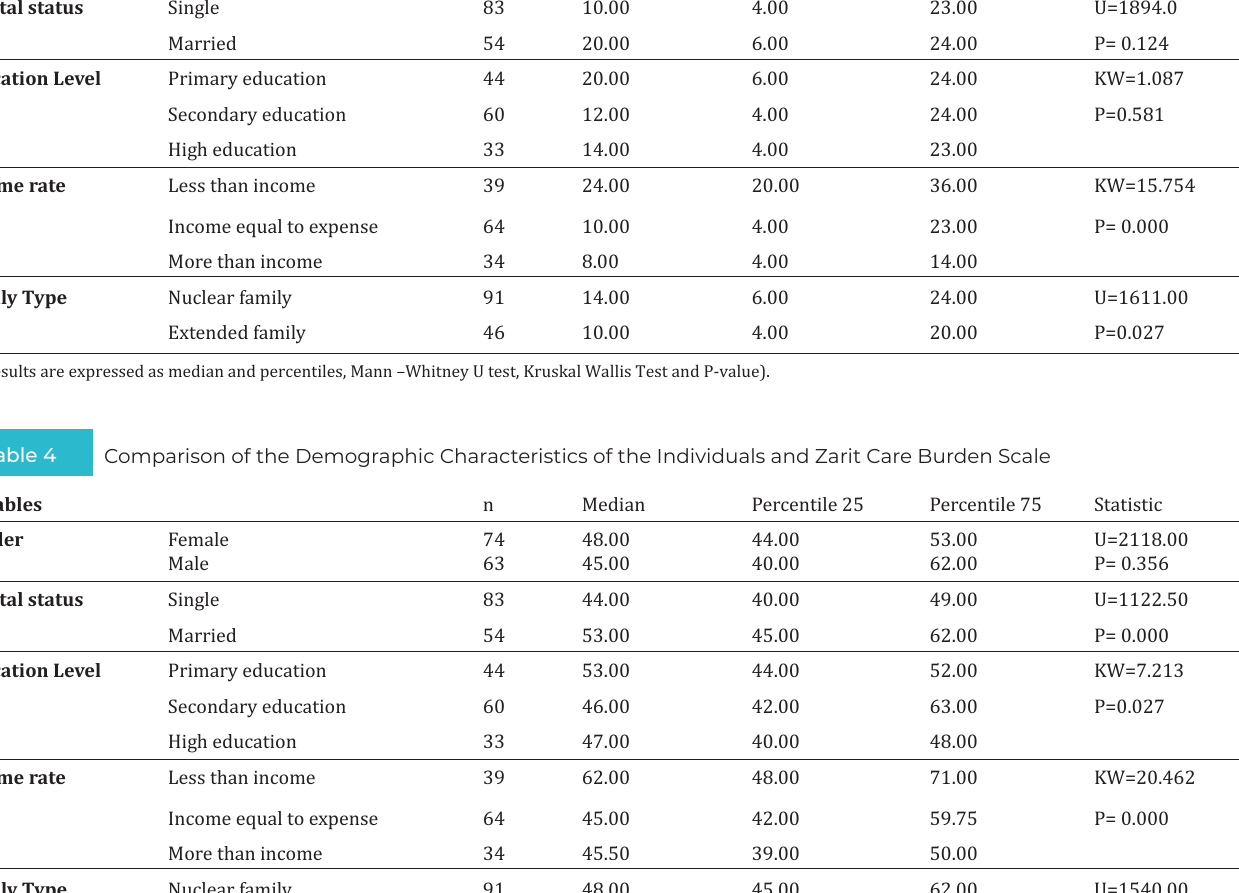
(The results are expressed as median and percentiles, Mann –Whitney U Test, Kruskal Wallis Test and P-value).